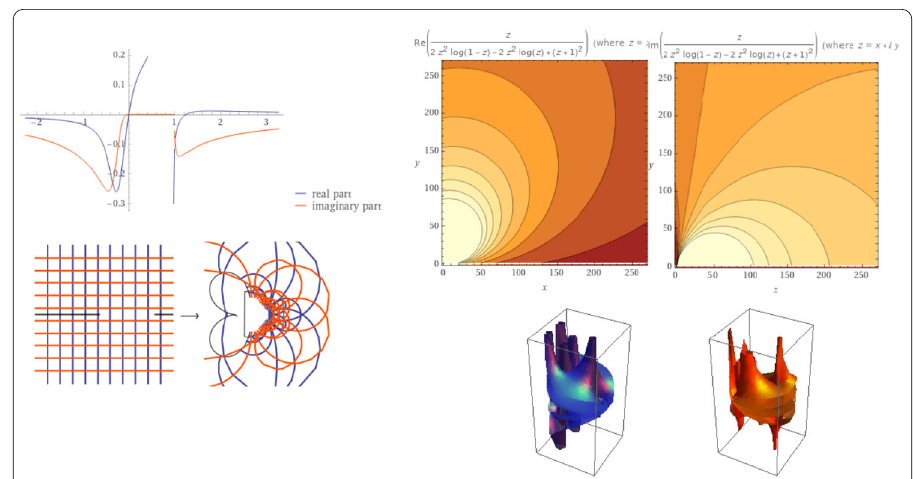
Figure 2 The behavior of solutions of Eq.(3.2), when α = 0.5, β =